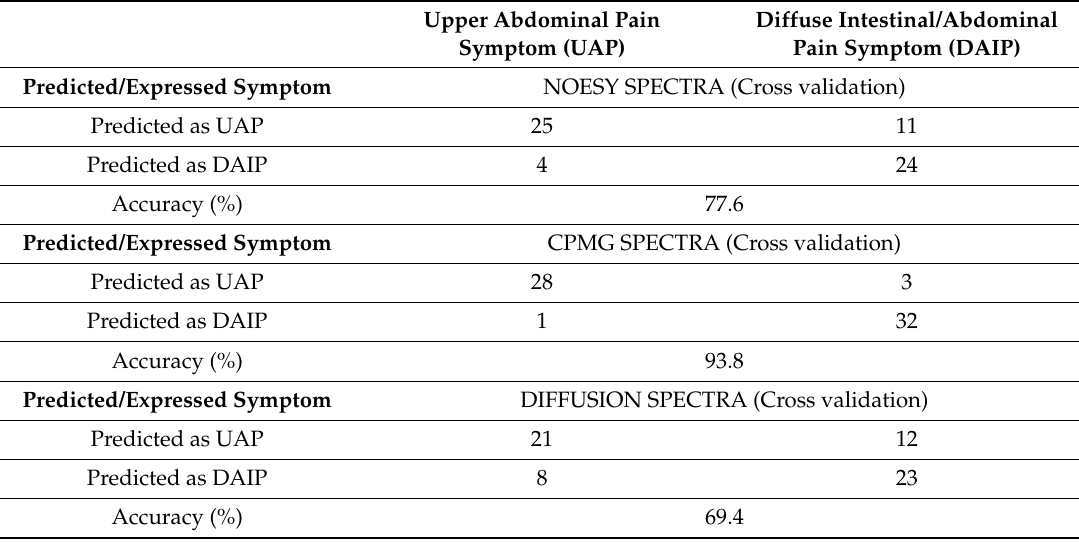
Table 1. Cross-Validation results (confusion matrices) and accuracies from the OPLS-DA analysis of NOESY, CPMG, and diffusion NMR spectra for the diseases with symptoms of severe upper abdominal pain (UAP) vs. the diseases with diffuse abdominal/intestinal pain